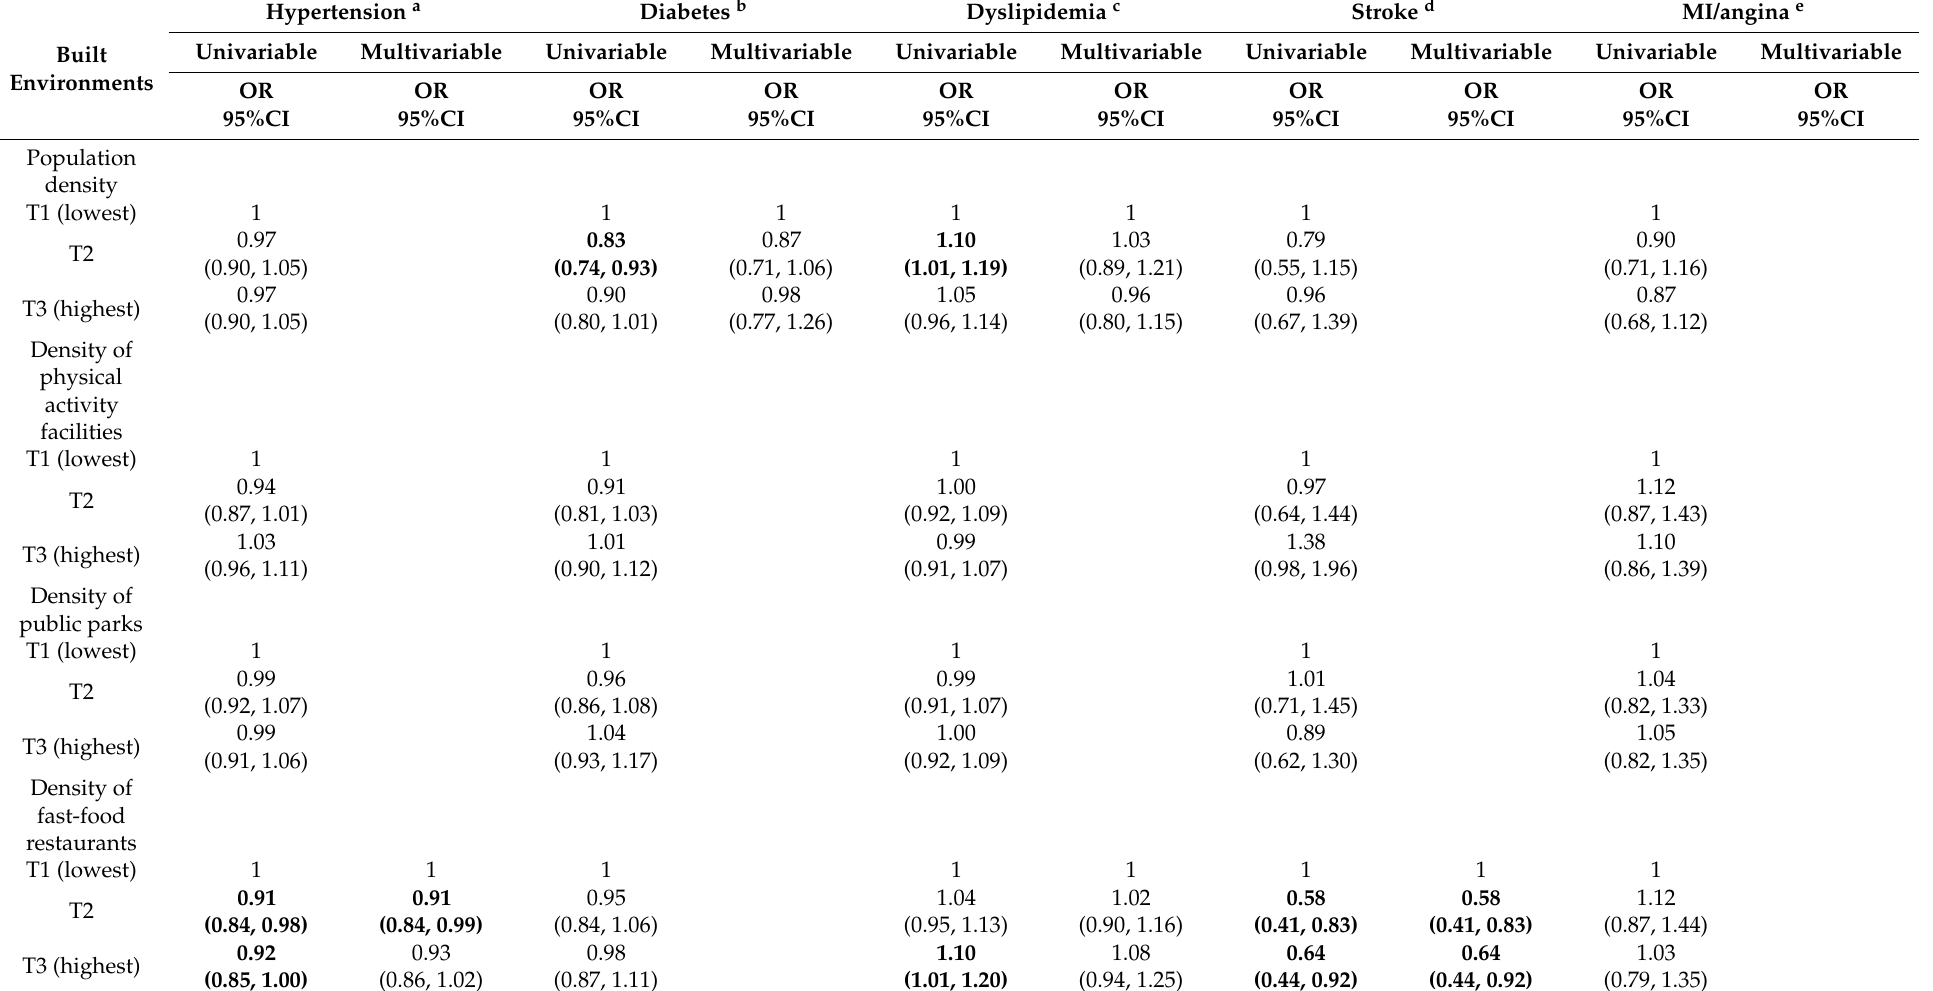
Table 3. Association between cardiovascular diseases and built environments in adults aged 40–50